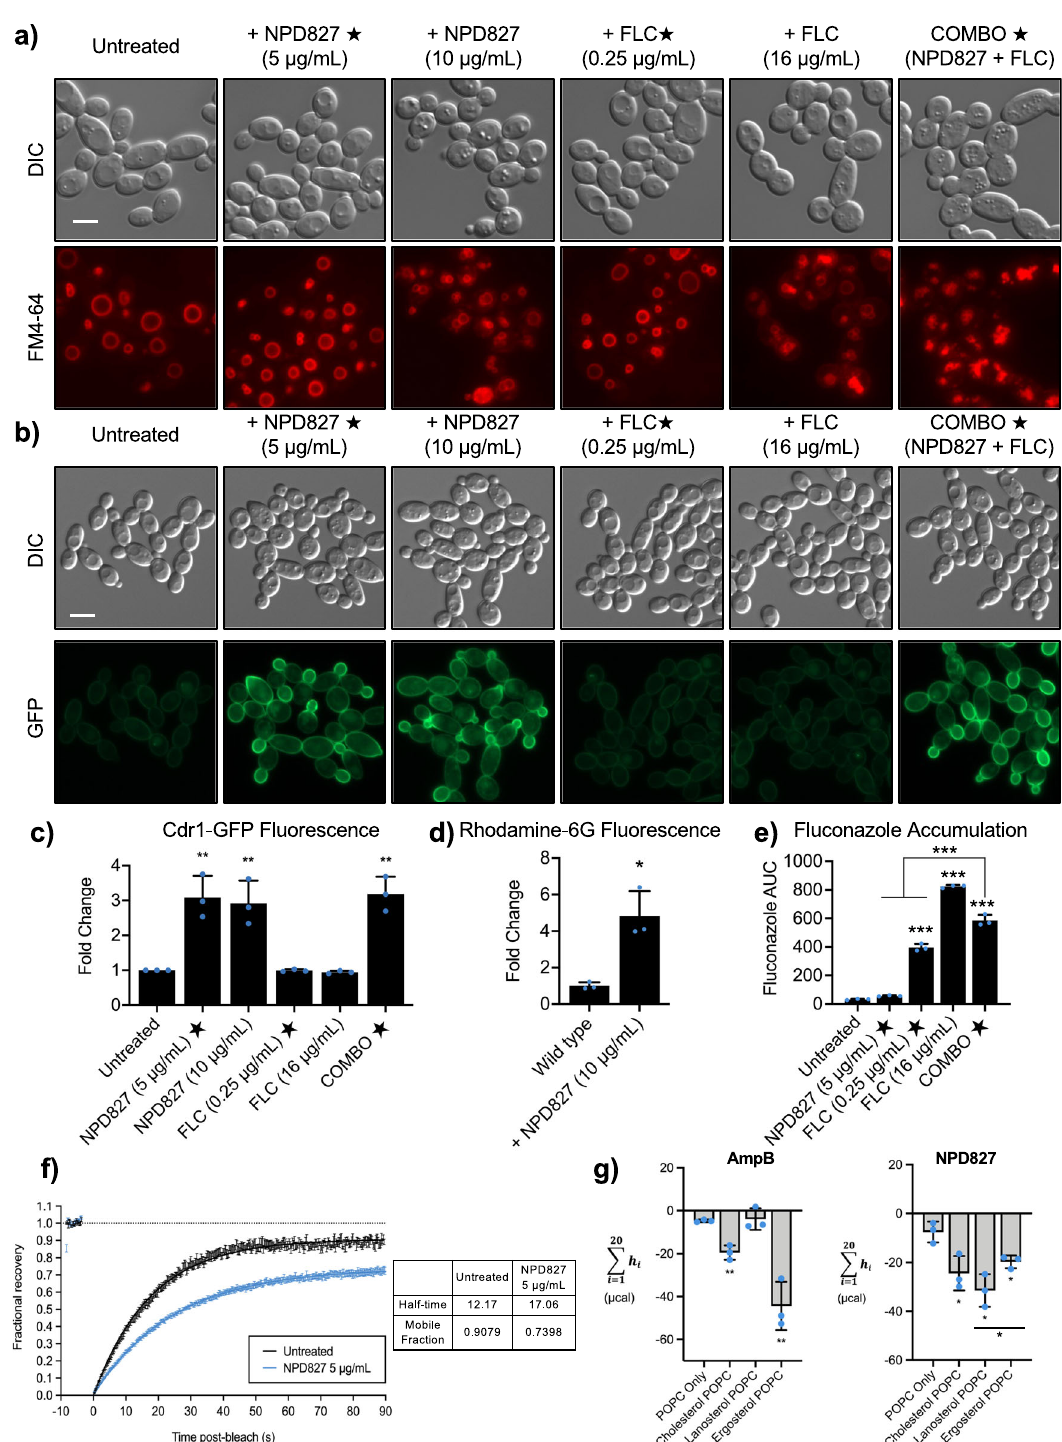
heterozygous non-synonymous mutation in UBI4 , a gene encoding the ubiquitin precursor peptide required for tagging of proteins for degradation by the vacuole via the MVB pathway. To verify the mutations identi fi ed by our sequencing analysis were necessary and suf fi cient for the resistant phenotype, we performed allele-swap experiments. The parental allele was introduced into the resistant mutant (RM) and reciprocally, the mutant allele was introduced into the parental strain. Expression of one allele of VPS4 D234Y , VPS4 G178E , or VPS20 E194 * in an erg3 Δ / Δ background conferred a level of resistance to NPD827